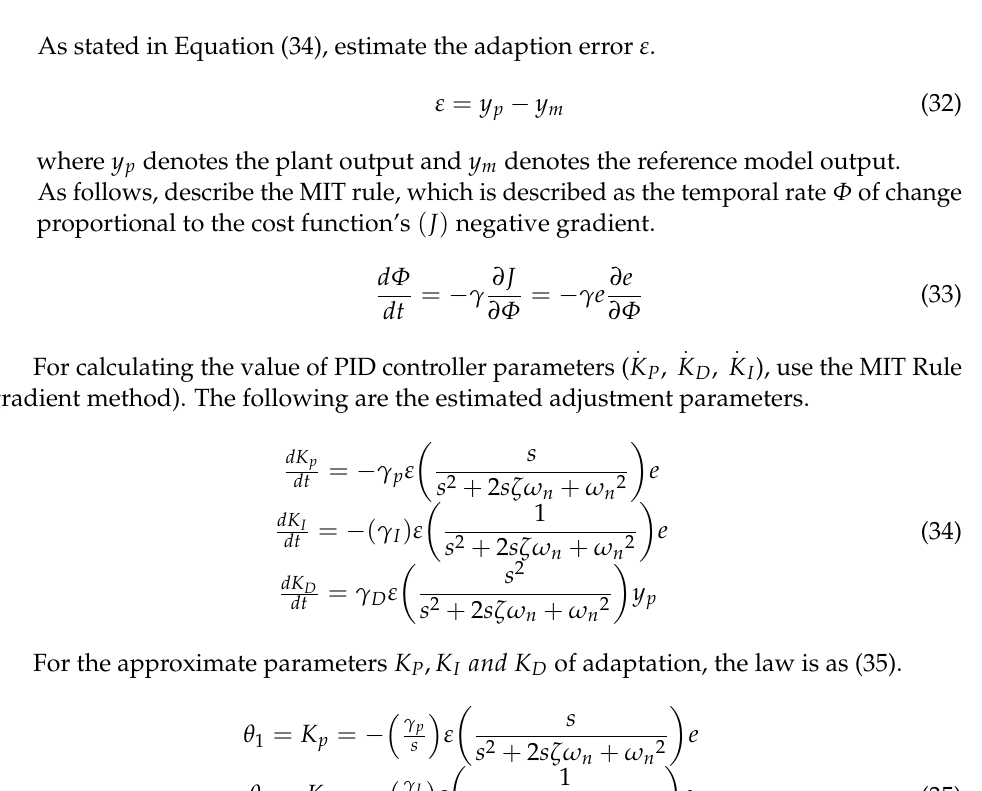
Figure 10. MRAC System with MIT Rules.